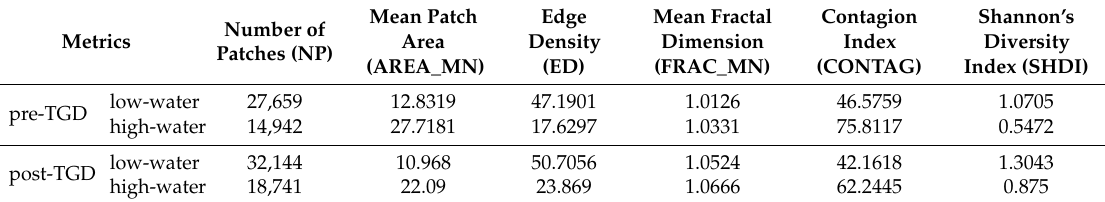
Table 4. Landscape metric evolution for the entire landscape (landscape level) from the pre- to the post-TGD